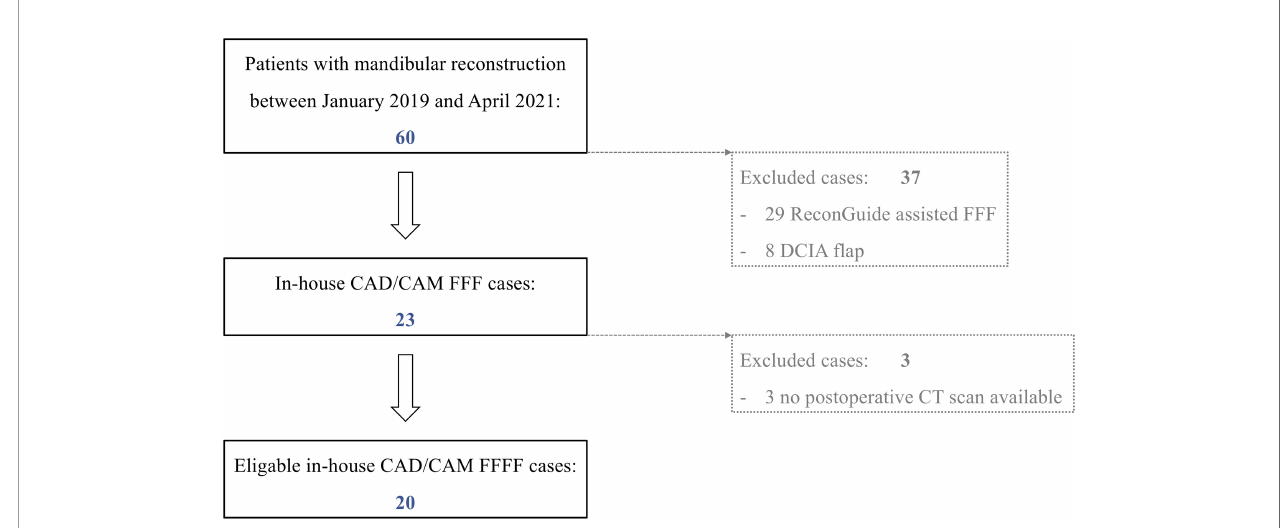
FIGURE 1 | Patient enrollment protocol of this exploratory cross-sectional study of a historical cohort. (FFF, free fi bula fl ap; DCIA, microvascular iliac crest fl ap, deep circum fl ex iliac